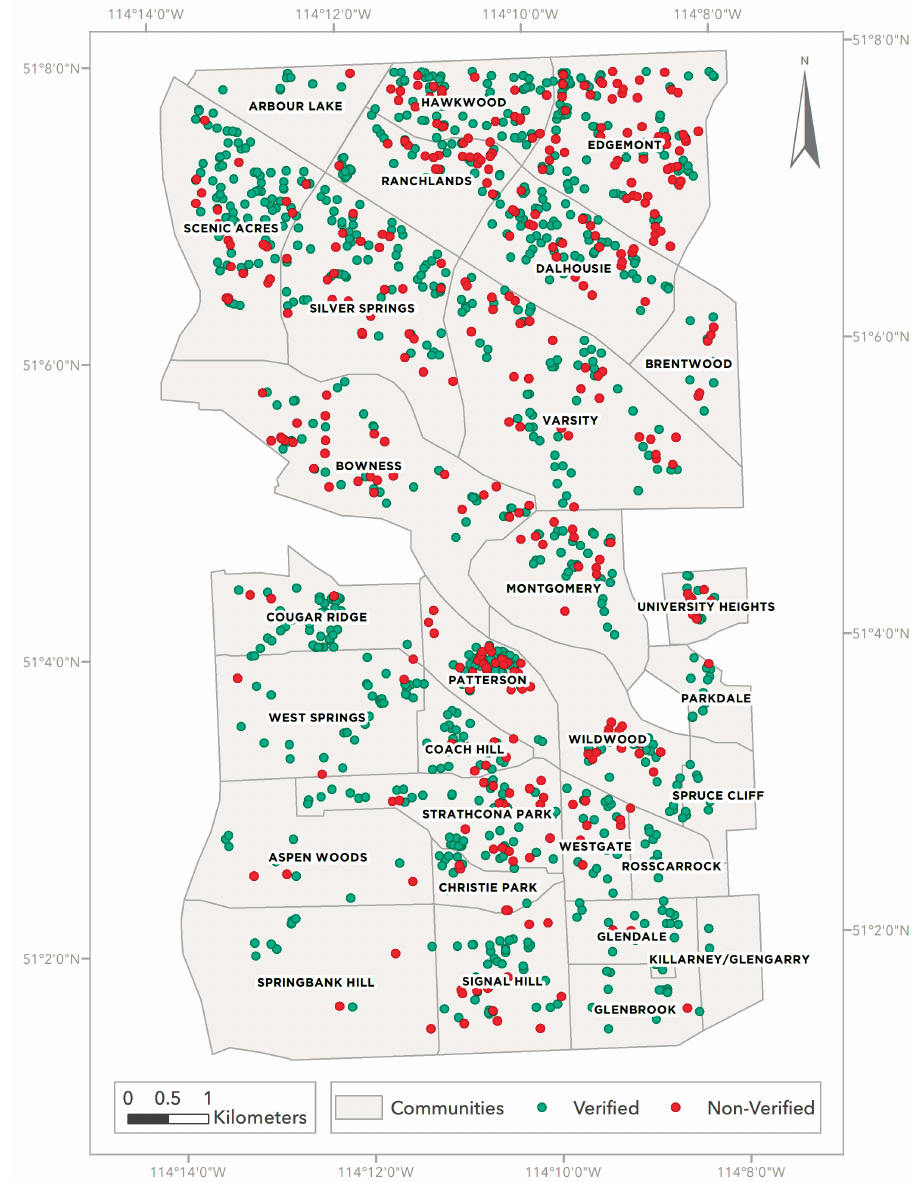
Figure 6. Locations of 1815 classified roofs in the study